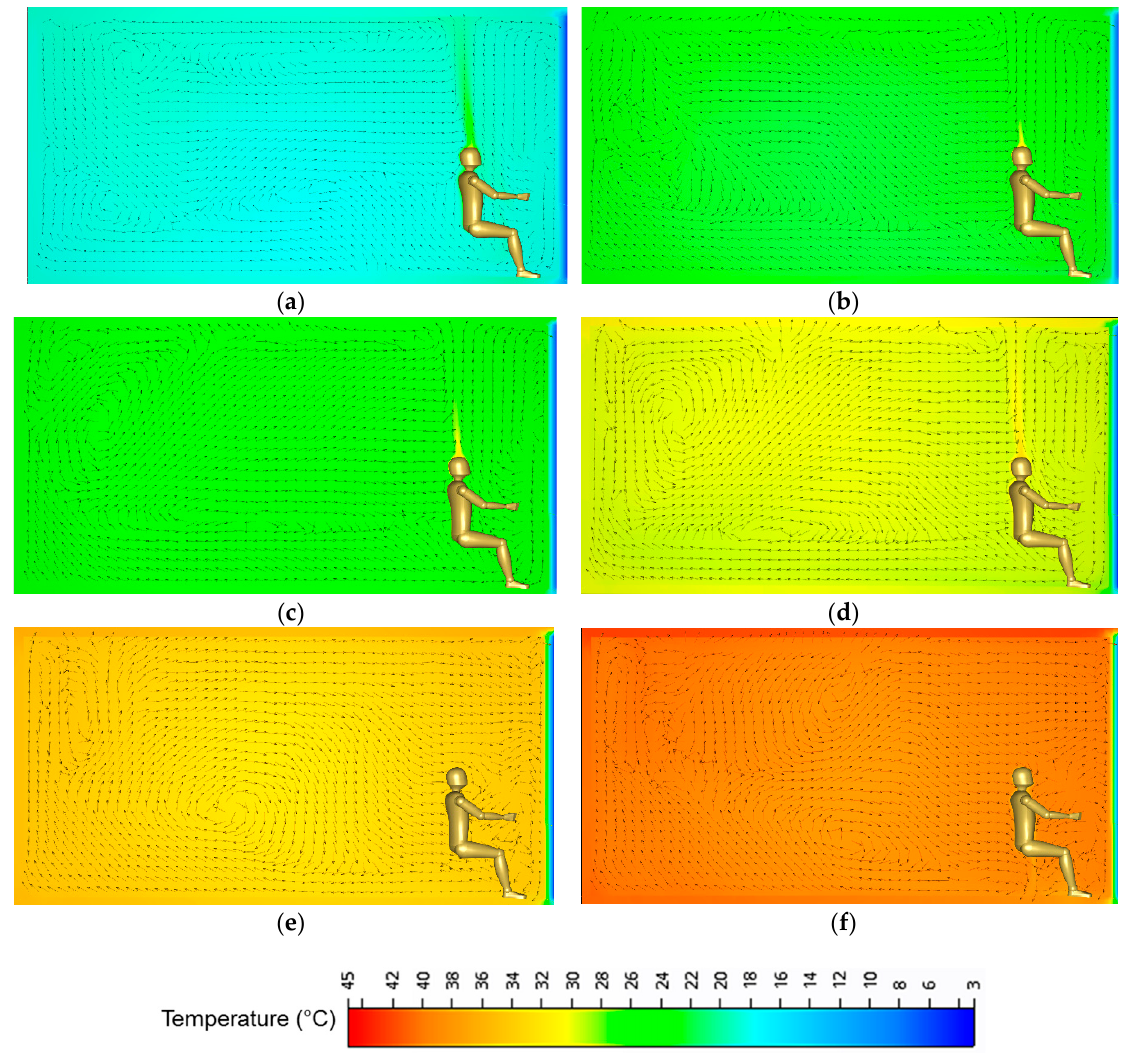
Figure 10. Temperature contour (x-y plane, z = 2 m) of the CFD simulations for the ceiling temperatures of 20 °C ( a ), 25 °C ( b ), 28 °C ( c ), 33 °C ( d ), 38 °C ( e ), and 45 °C ( f ) in the scenario with one low-performance façade.